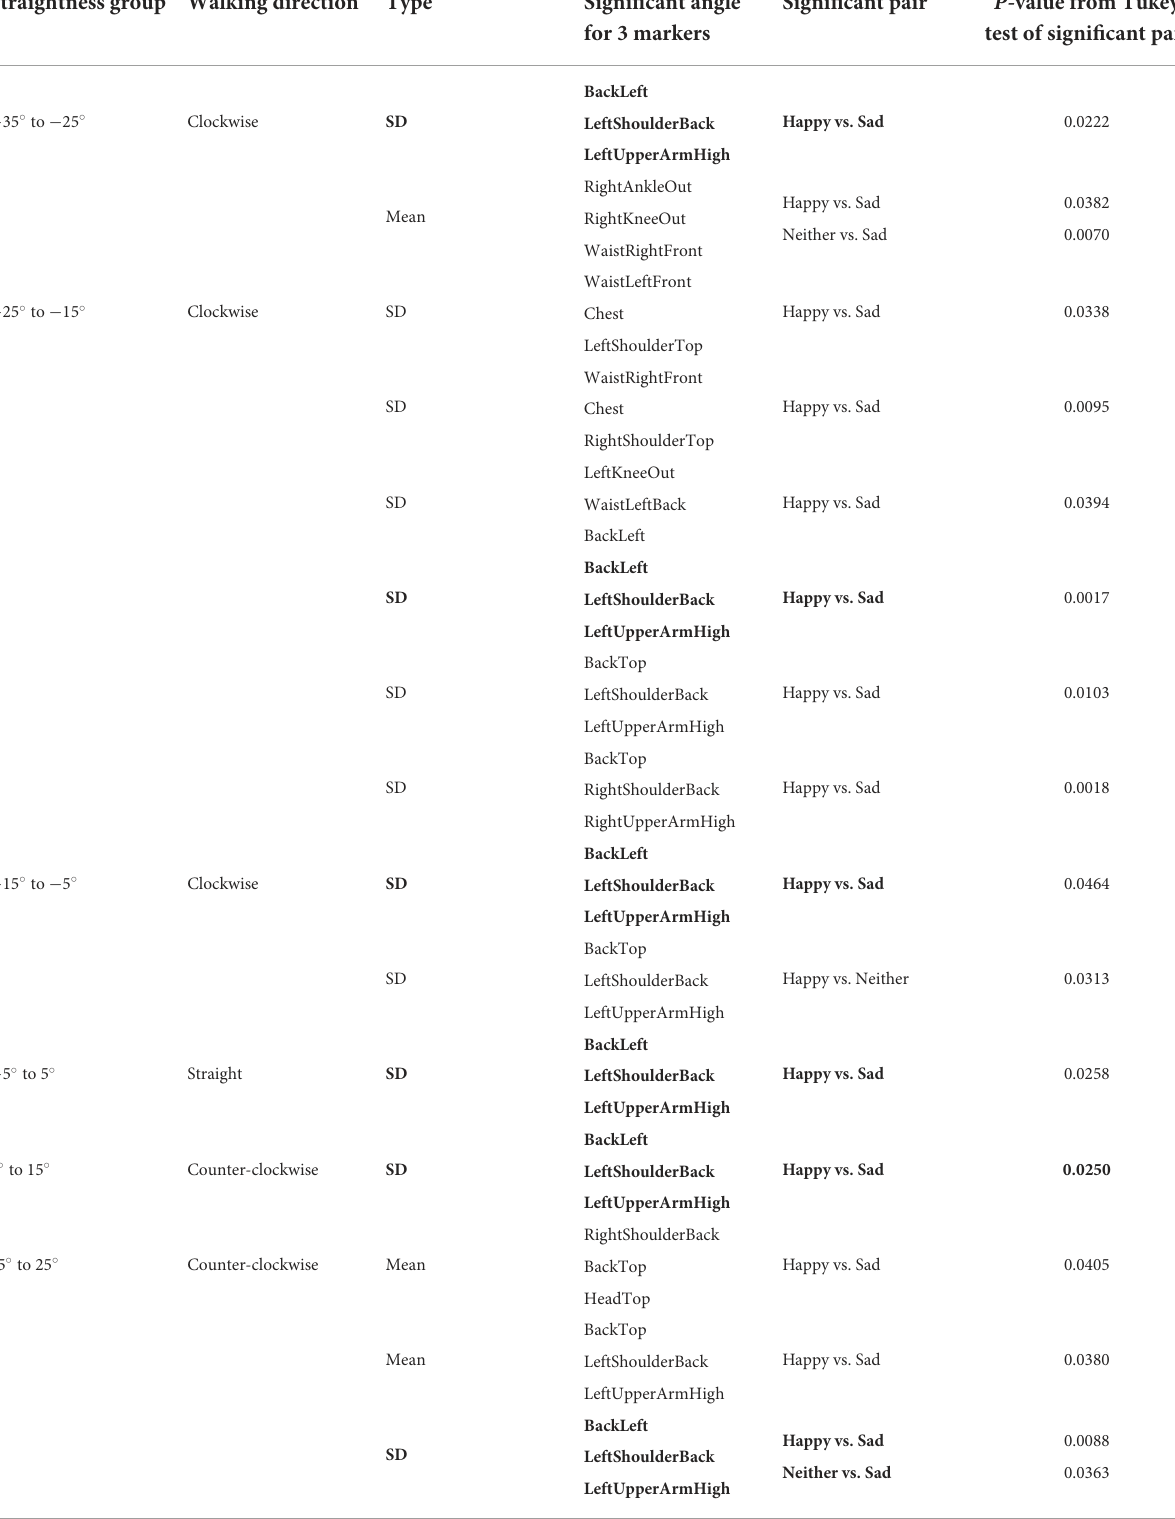
TABLE 7 Tukey test results of significantly different mean and SD of each angle in each straightness group (factor: reported emotion). Straightness group Walking